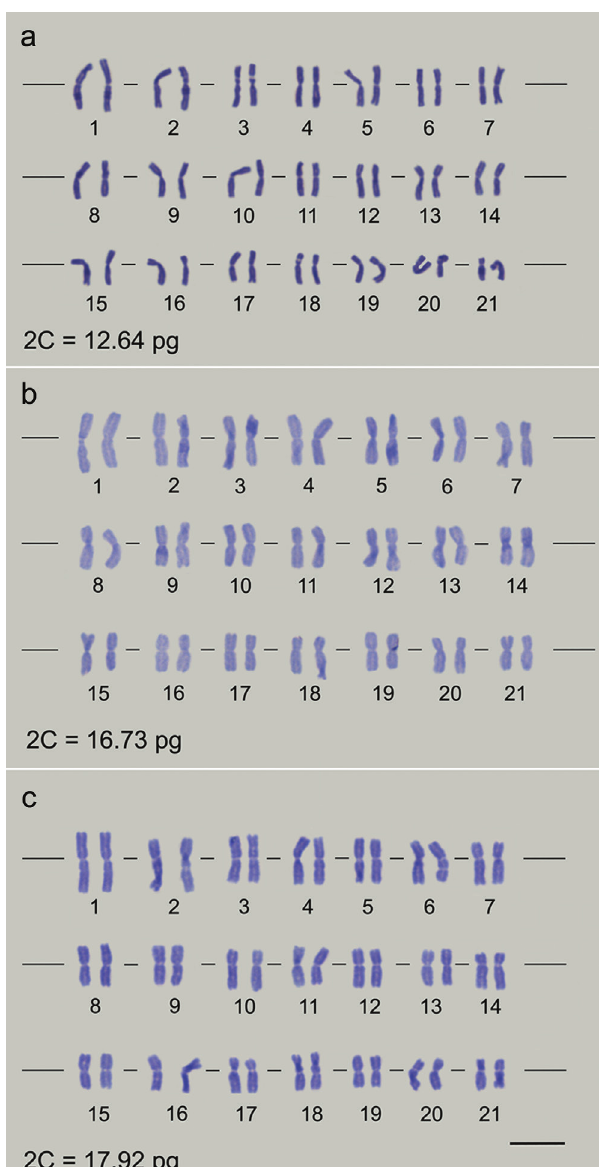
Figure 1. First karyograms of Bromus species, displaying 2n = 6x = 42 chromosomes: a B. catharticus b B. brachyanthera and c B. auleticus . a B. catharticus displayed eleven metacentric (1, 4, 5, 7, 8, 9, 10, 11, 14, 17 and 20) and ten submetacentric chromosomes (2, 3, 6, 12, 13, 15, 16, 18, 19 and 21) b B. brachyanthera exhibited 13 metacentric (1, 2, 4, 5, 6, 9, 10, 13, 15, 16, 17, 19 and 21) and eight submeta- centric chromosomes (3, 7, 8, 11, 12, 14, 18 and 20) c B. auleticus presented eleven metacentric (1, 3, 4, 5, 6, 8, 9, 11, 15, 18 and 19) and ten submetacentric chromosomes (2, 7, 10, 12, 13, 14, 16, 17, 20 and 21). Note the morphologically similar chromosomes: a 12–13 in B. catharticus b 11–12 and 15–16 in B. brachyanthera , and c 3–4 in B. auleticus . Bar = 5